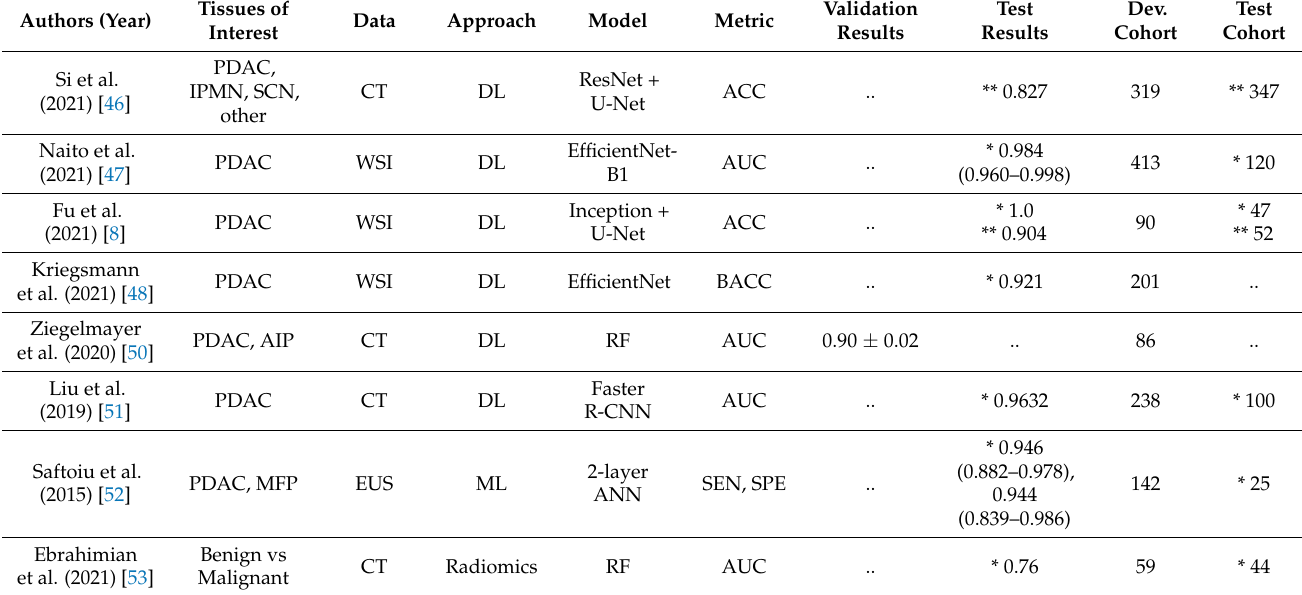
Table 2. Summary of papers on AI for PDAC differential diagnosis. The performance for the validation and test sets is reported with respective 95% Confidence Interval or standard deviation when it was